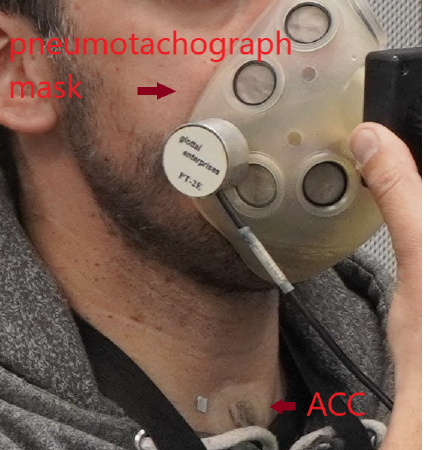
Figure 6. Experimental setup with oral airflow (pneumotachograph) mask and accelerometer sensor (ACC) on neck-surface